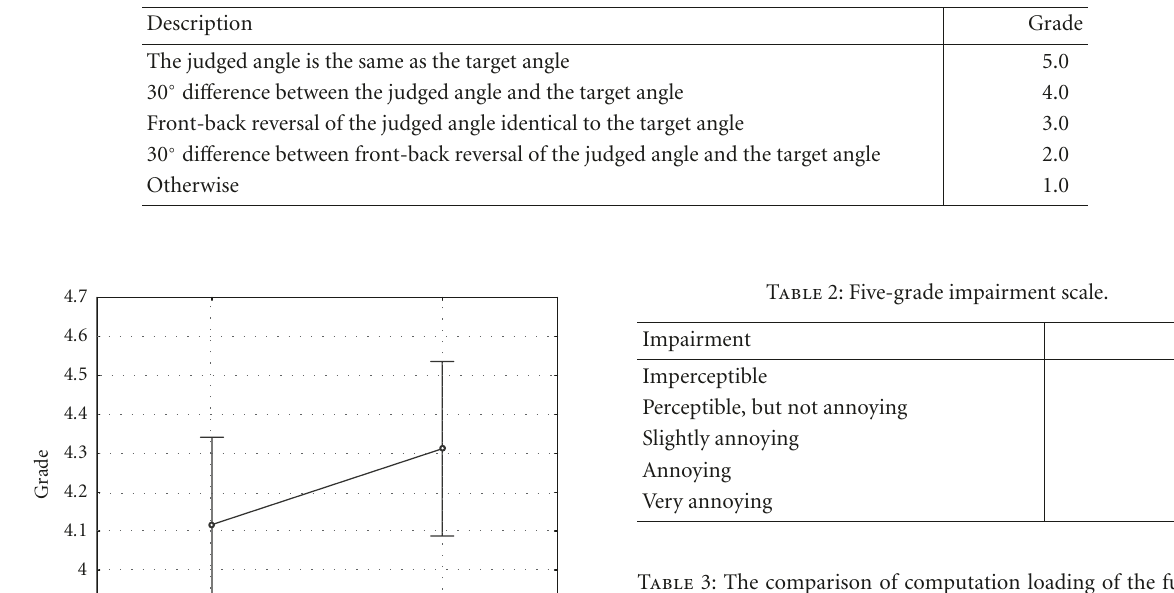
Table 1: Description of five levels of grade for the subjective localization test.